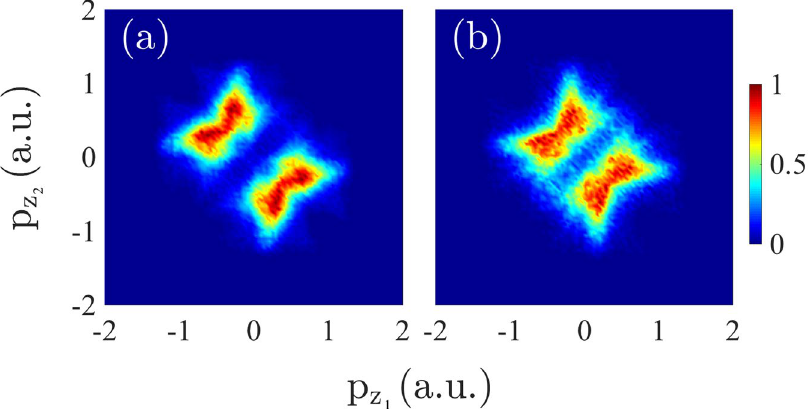
Figure 6. Correlated electron momenta at an intensity of 0.85 × 10 14 W/cm 2 for the delayed pathway of double ionization for the case when the electron that ionizes second is electron 2 ( a ) and electron 1 ( b ). Each double differential distribution is divided by its maximum value.